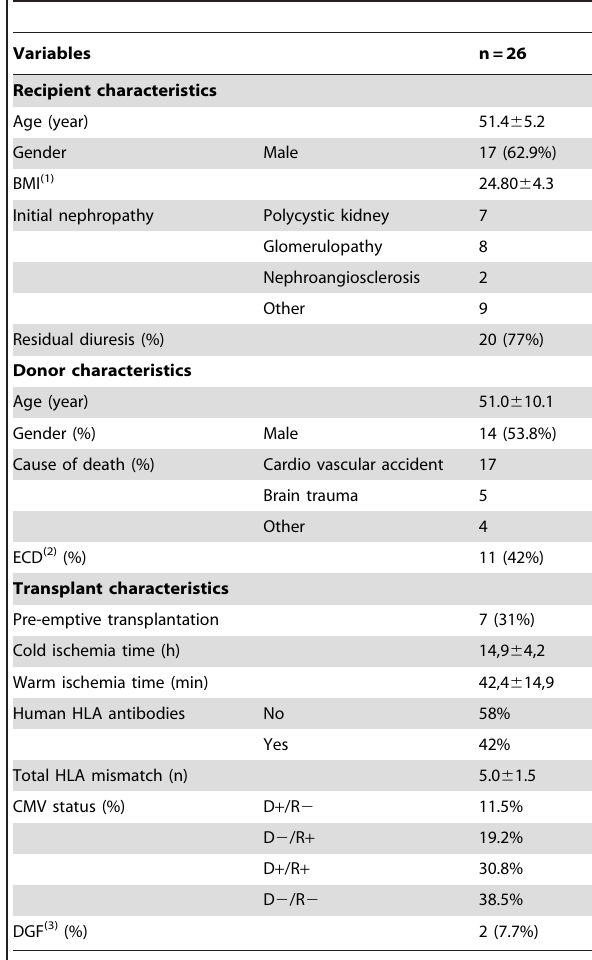
Table 1. Baseline demographic and clinical characteristics of recipients and